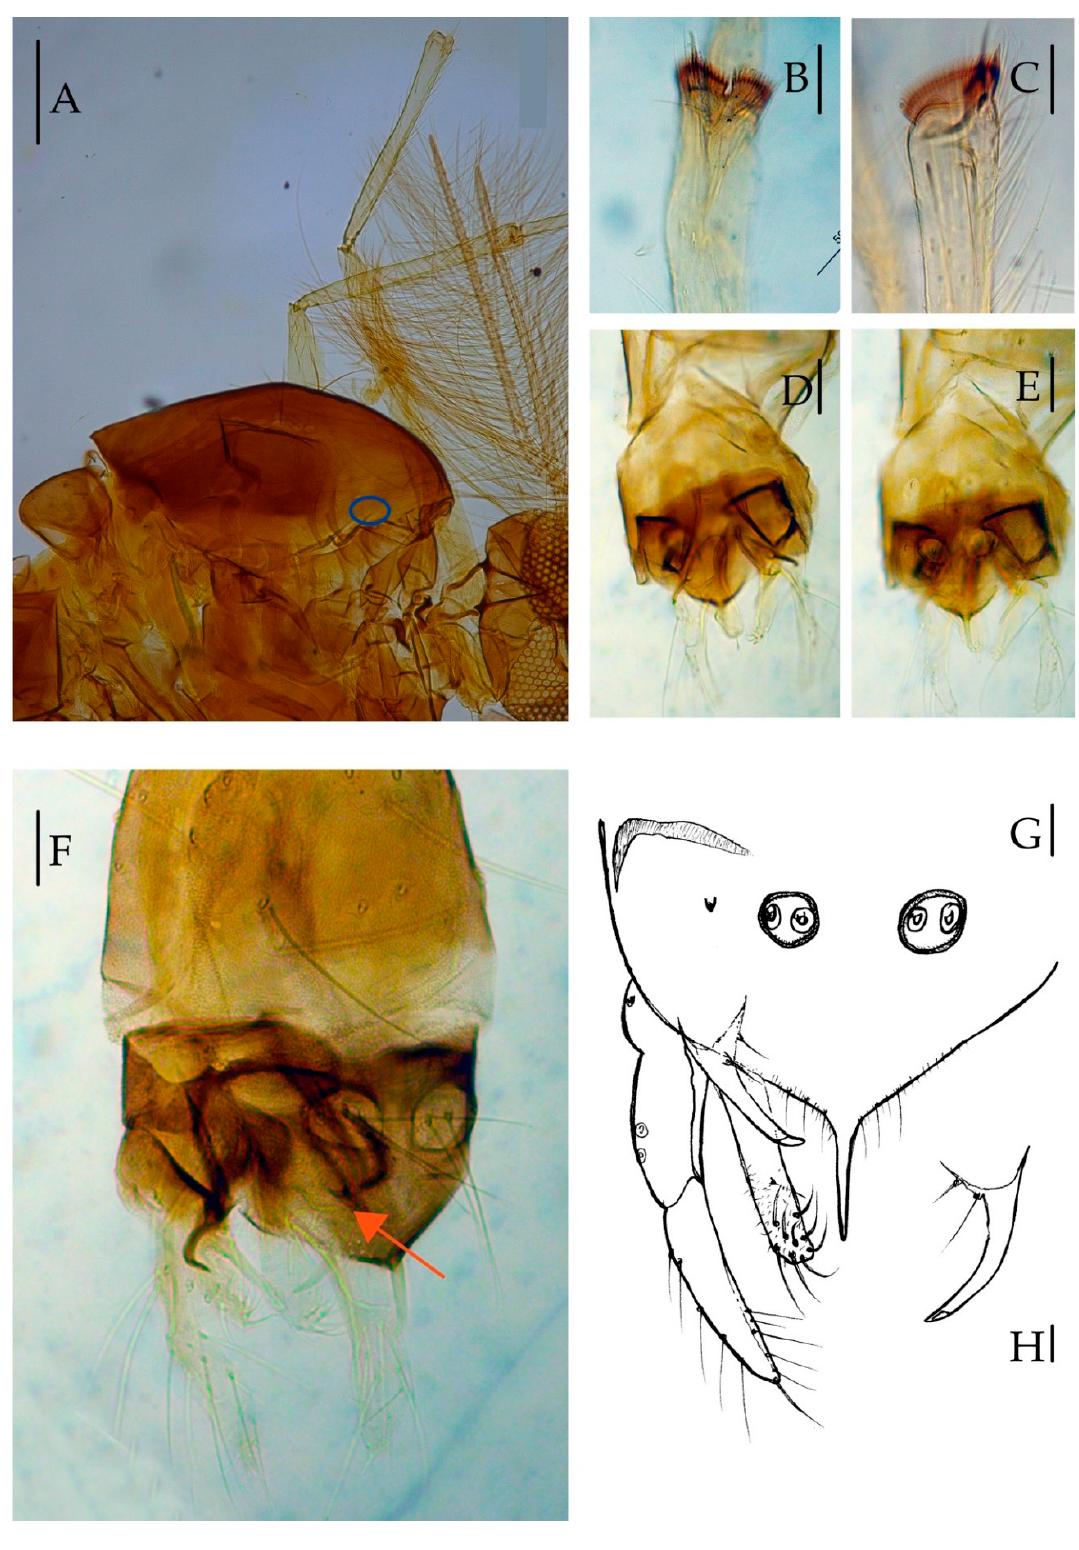
Figure 8. Yaeprimus tropicus comb. n. , male. ( A ) Thorax, head, lateral view; ( B ) mid tibia; ( C ) hind tibia; ( D ) hypopygium, ventral view; ( E ), hypopygium, dorsal view; ( G ), hypopygium, illustration, dorsal view; ( H ) superior volsella. Scale bar: A, 200 µm; B–F, 100 µm. A, ( F ) Holotype (CCA. 40G]); B–C: Paratype (GEN. 268AL); D–E, G: Paratype (GEN. 265AL).